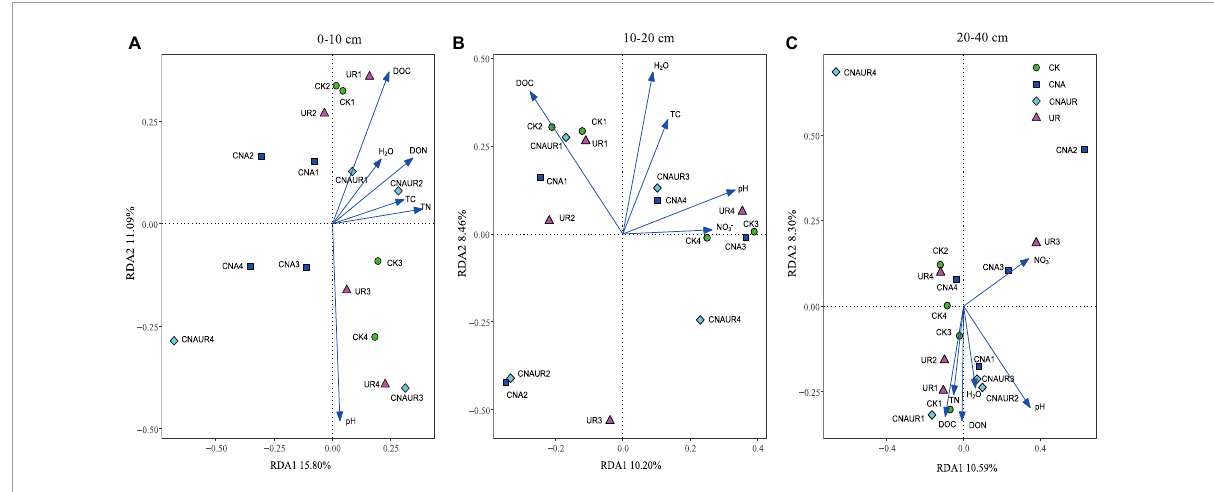
FIGURE8 Redundancy analysis (RDA) of the relationship between fungal community composition at the operational taxonomic (OTU) level and soil physicochemical properties across treatments in three soil layers, 0–10 cm (A) , 10–20 cm (B) , and 20–40 cm (C)